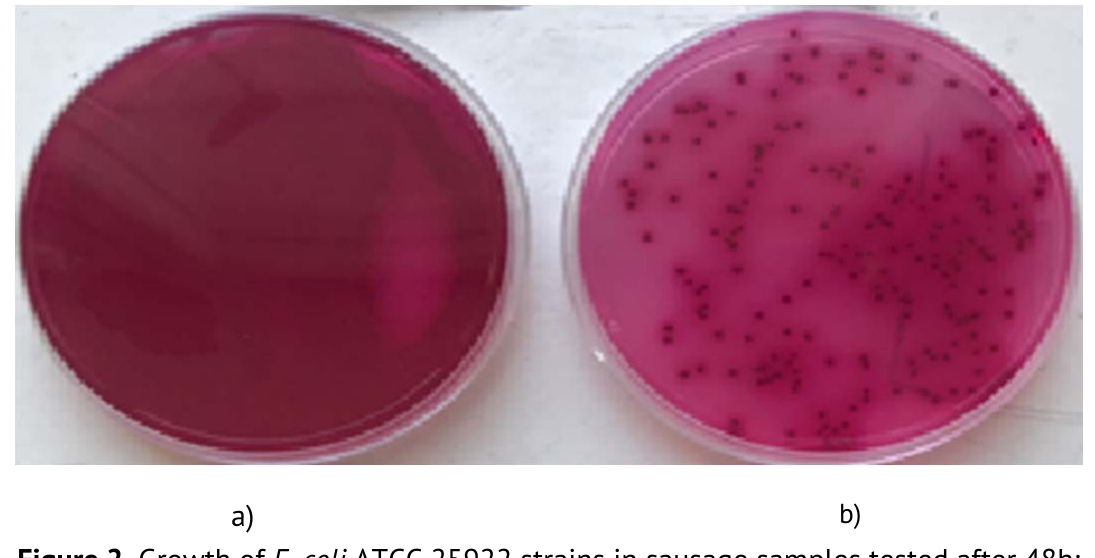
Figure 2. Growth of E. coli ATCC 25922 strains in sausage samples tested after 48h: